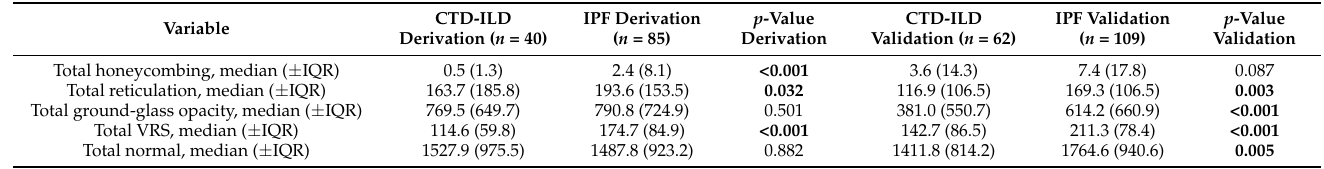
Table 2. Univariate CALIPER variables stratified by diagnosis at two tertiary medical centers (labeled derivation and validation). Variable